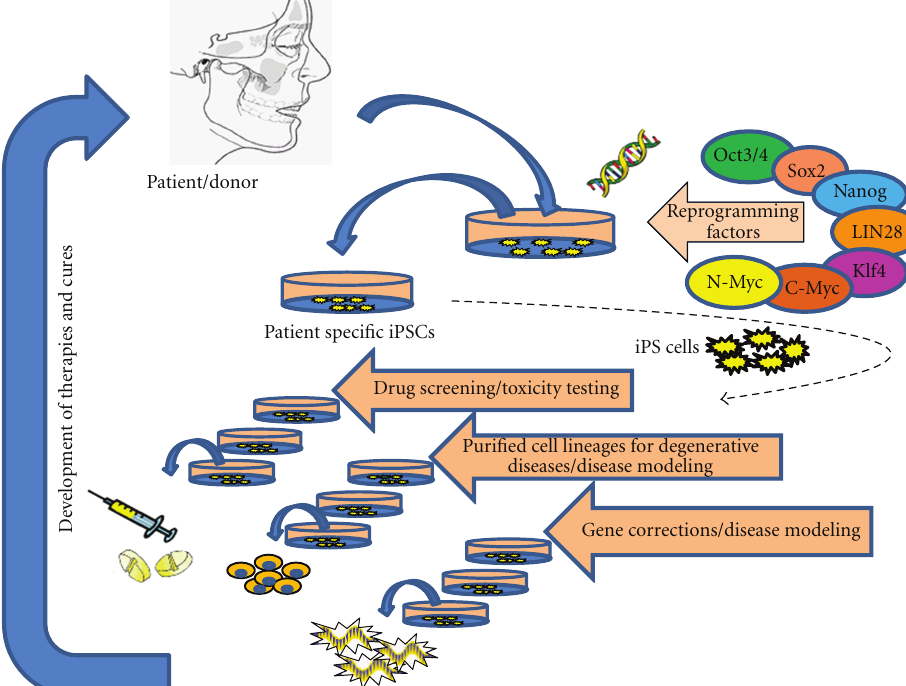
Figure 1: A schematic representation of the human iPSCs